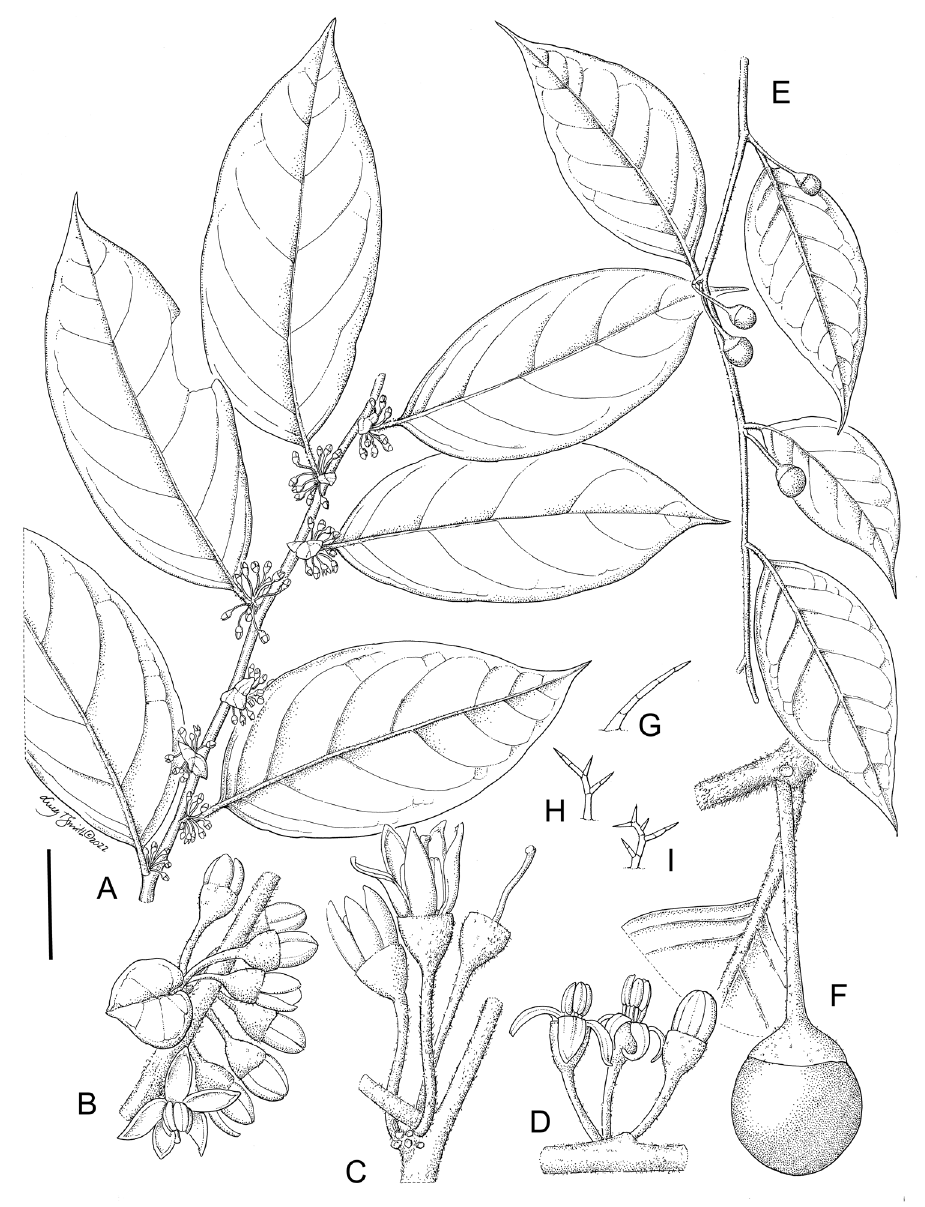
Figure 16. Lycianthes cladotrichota (Bitter) Bitter A flowering branch B inflorescence with long-styled flowers C long-styled flower D short-styled flowers E fruiting branch F berry G, H trichomes from stem I trichome from calyx. ( A, G, H Streimann & Katik NGF-30479 B, I Takeuchi 22832 C Crutwell 2310 D photograph of James et al. SAJ-1385 E, F Takeuchi 12379 ). Drawing by Lucy Smith. Scale bars: 4 cm ( A, E ); 7 mm ( B, C ); 7.5 mm ( D, F ); 0.9 mm ( G–I